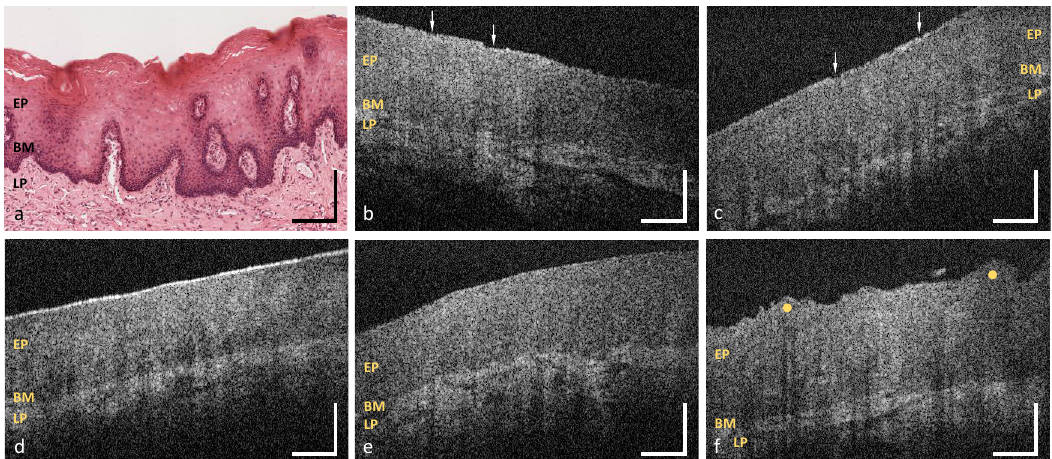
Figure 8. OCT images of the buccal mucosa ( b – f ). The sample pictures represent the anterior (MP6) ( b , c ), the central (MP7) ( d ) and the posterior buccal region (MP8) ( e , f ). Exemplary HE stained histological cross sections depicting the buccal mucosa ( a ) ([44] modified). EP: epithelium, BM: basement membrane, LP: lamina propria; Arrows: epithelial surface alteration, Yellow dots: uneven surface profile. Scale bars: 200 µ m.